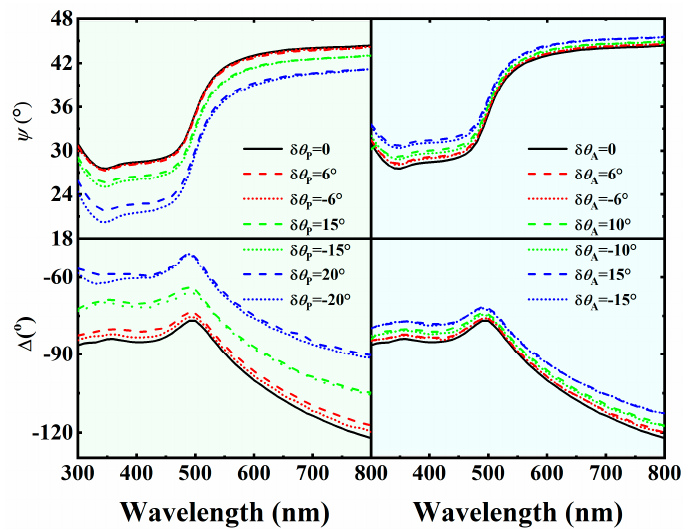
Figure 9. Ellipsometric parameters measured with azimuthal errors of the same absolute values in the opposite direction.